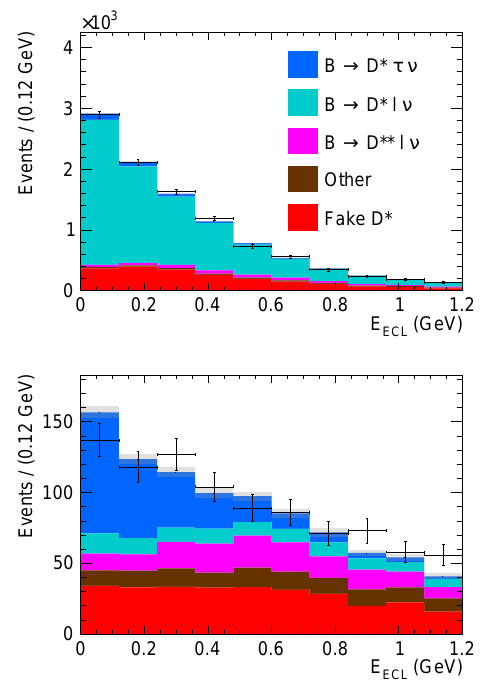
Figure 3: Fit projections of the D ∗ 0 (cid:96) − sample as a function of E ECL . The upper plot shows the full classifier region, while the lower plot shows the signal region, defined by the cut class > 0 .